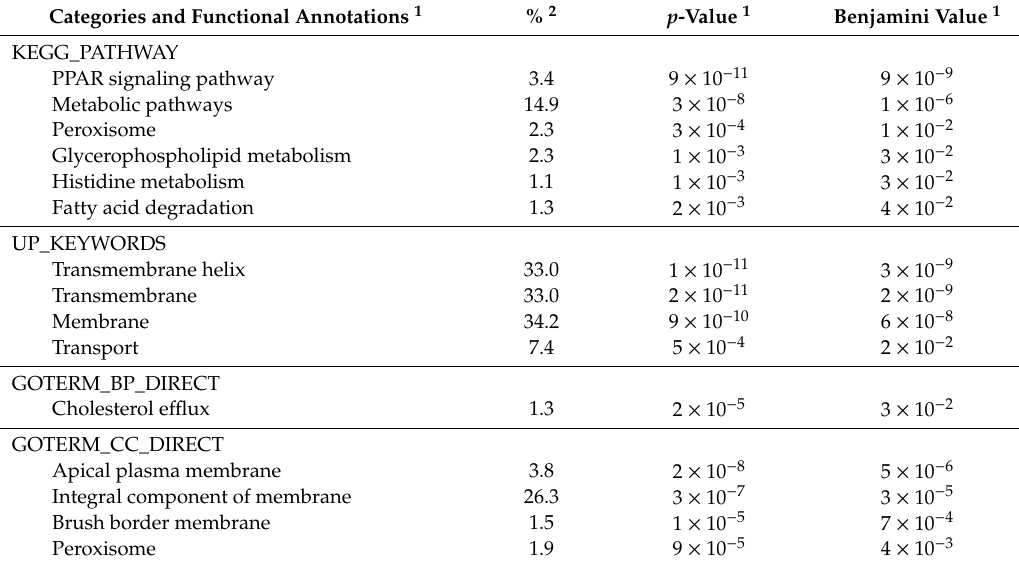
Table 3. List of DAVID (Database for Annotation, Visualization and Integrated Discovery) functional annotations significantly enriched of di ff erentially expressed genes (DEGs) in the jejunal mucosa of broiler chickens.